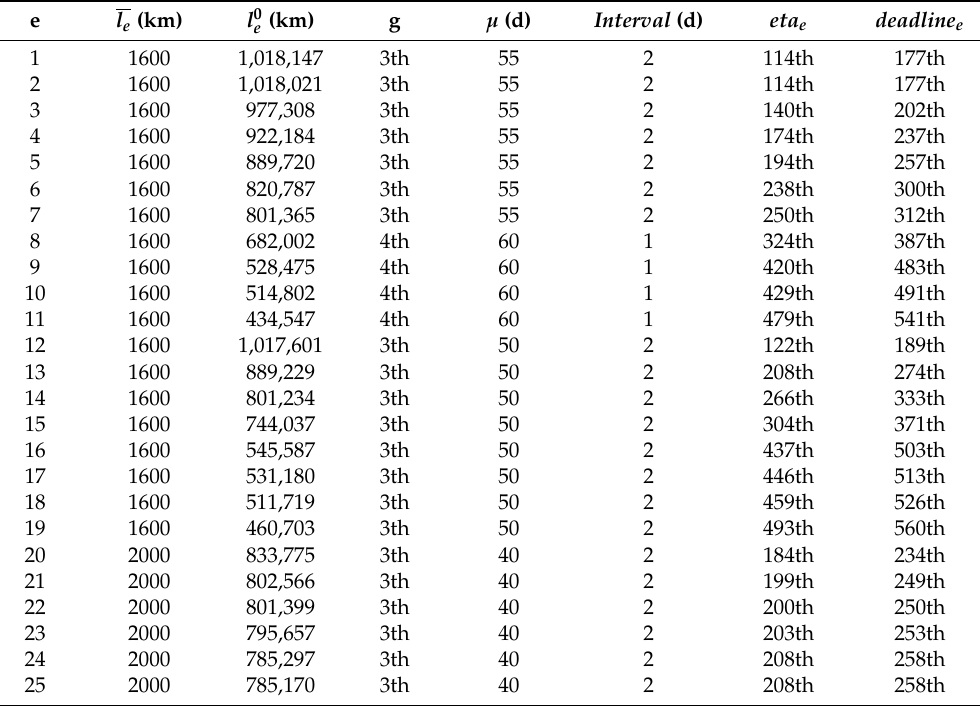
Table 4. Initial conditions of all